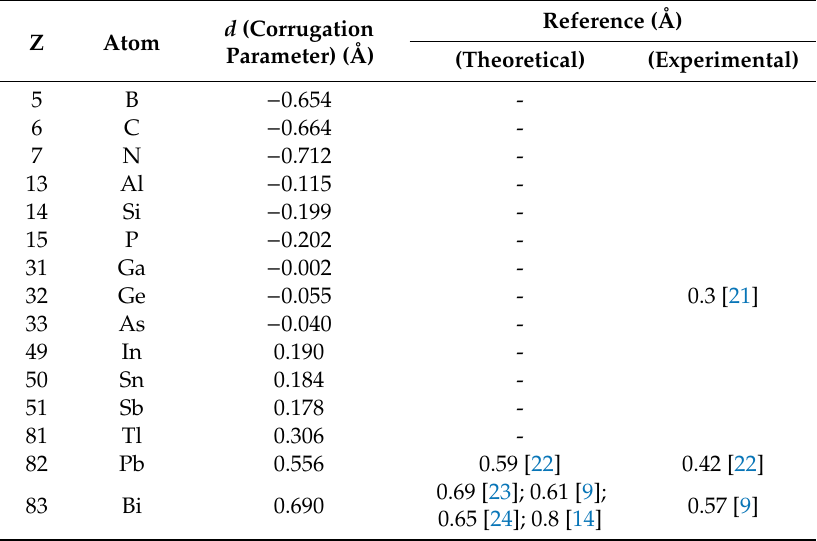
Table 1. Comparison of corrugation parameters from our calculation and prior works of calculations and experiments, sorted by atomic number Z. d denotes the corrugation